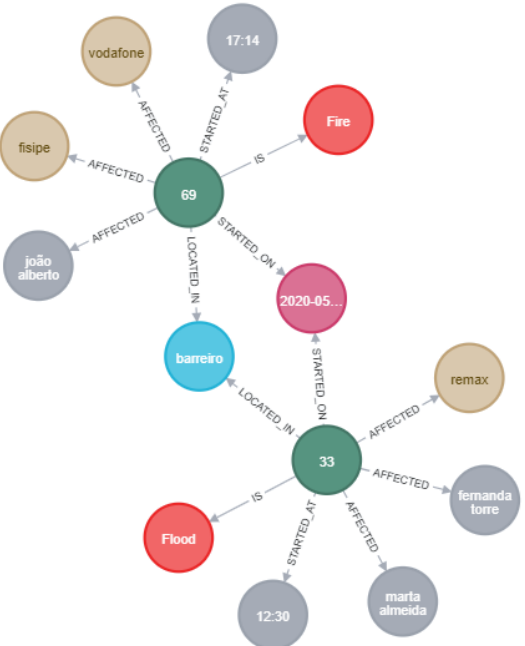
Figure 6. Knowledge graph after all 6